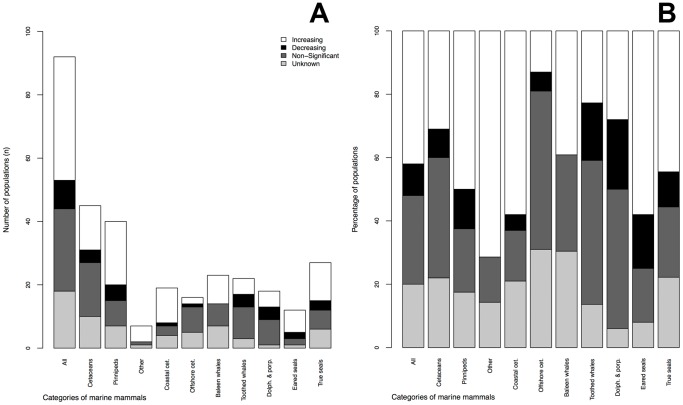
Trend classification for marine mammal populations by different categories as numbers (A) and proportions (B).Summary of results from robust weighted log-linear regressions for 92 (non-nested, including the largest possible areas) marine mammal populations. “Other” includes sirenians, polar bears and sea otters.